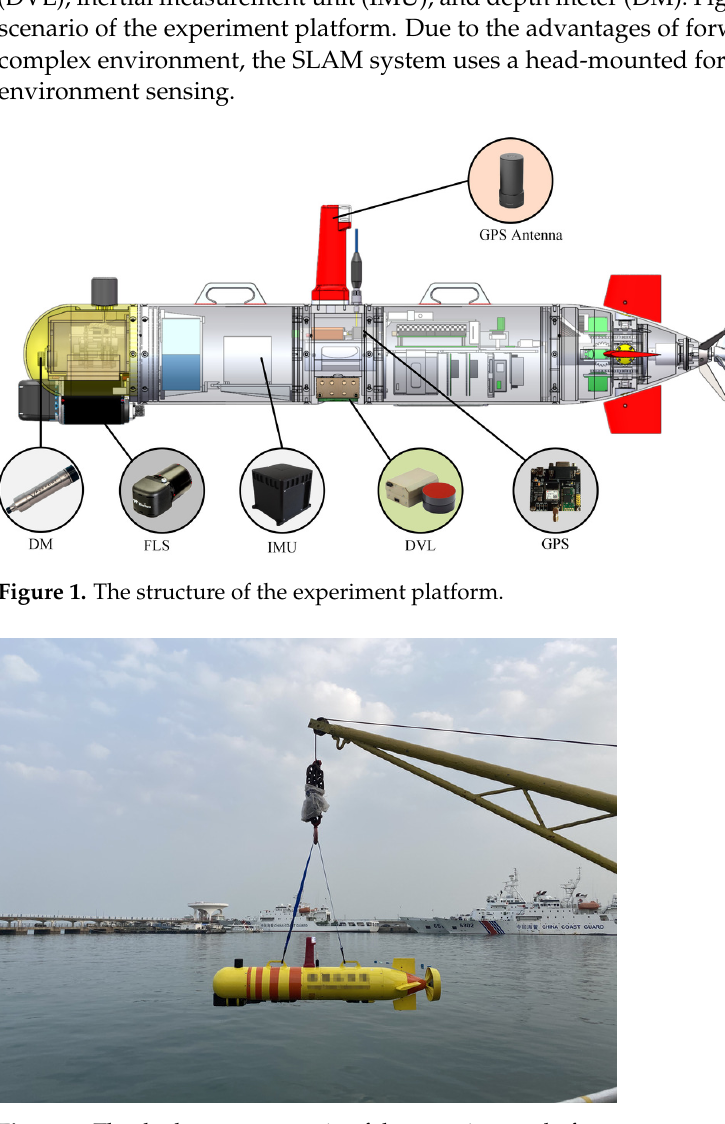
Figure 2. The deployment scenario of the experiment